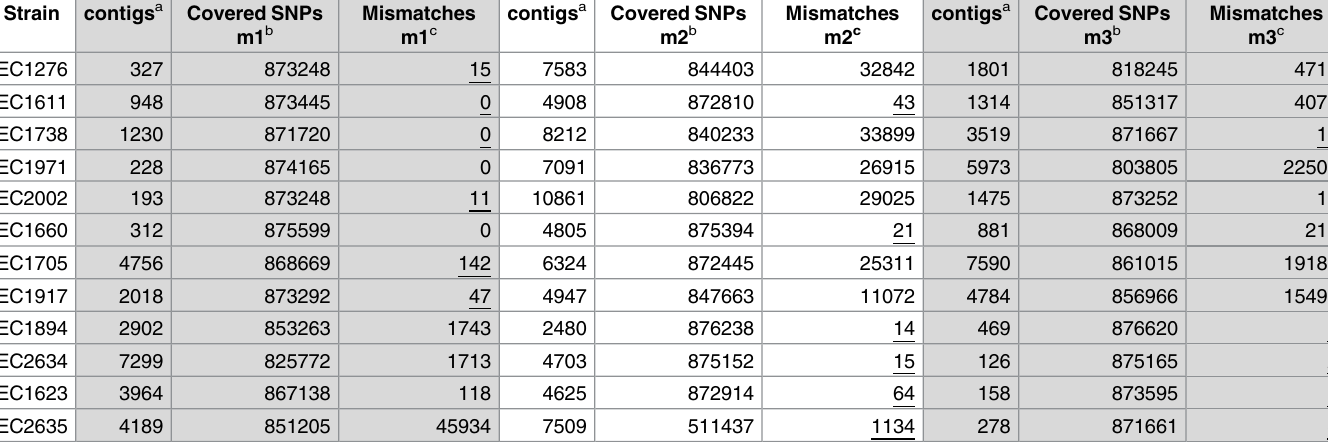
Table 4. Number of contigs, single nucleotide polymorphic (SNP) sites and nucleotide mismatchesat SNP sites. Strain contigs a Covered SNPs